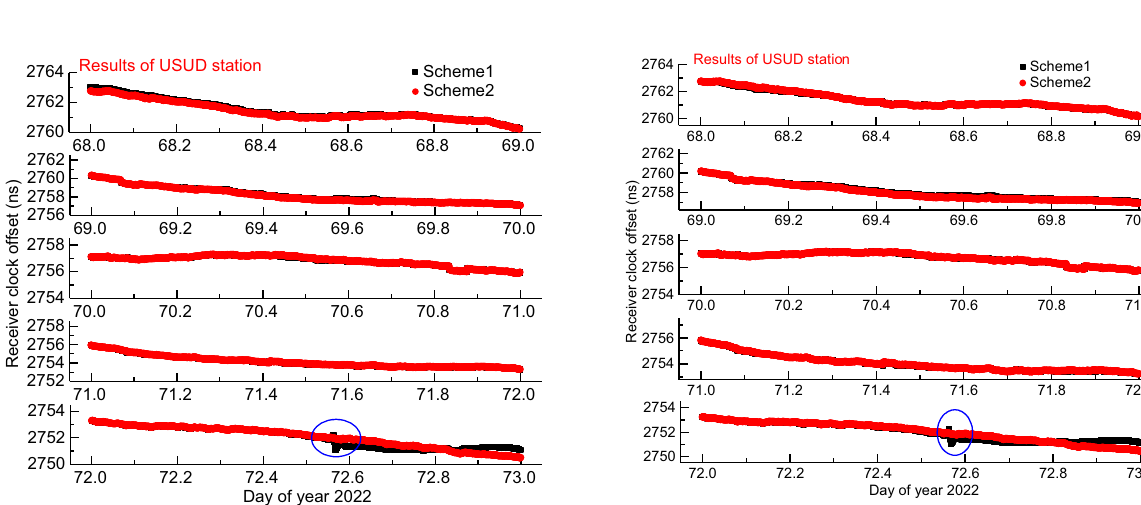
Fig. 11 USUD receiver clock offsets from BDS-3/GPS PPP in Scheme